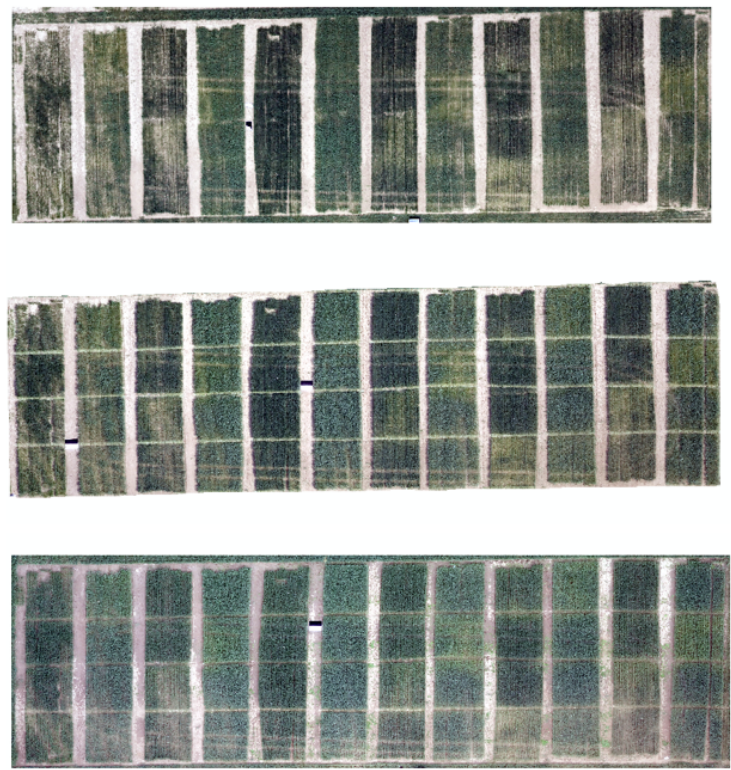
Figure 7. UAV images obtained at different growth stages.